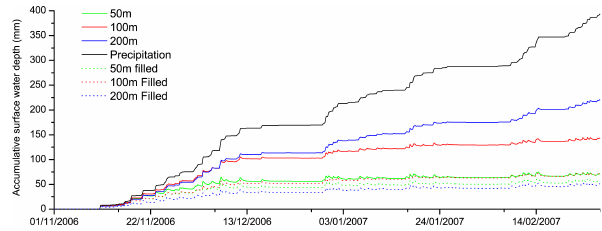
Fig. 9. Surface flow simulations for the 100m resolution DEM in MIKE SHE.